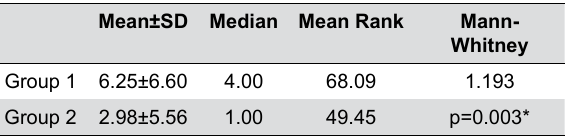
Table 3- Comparison between Groups 1 and 2 - Mann-Whitney U test